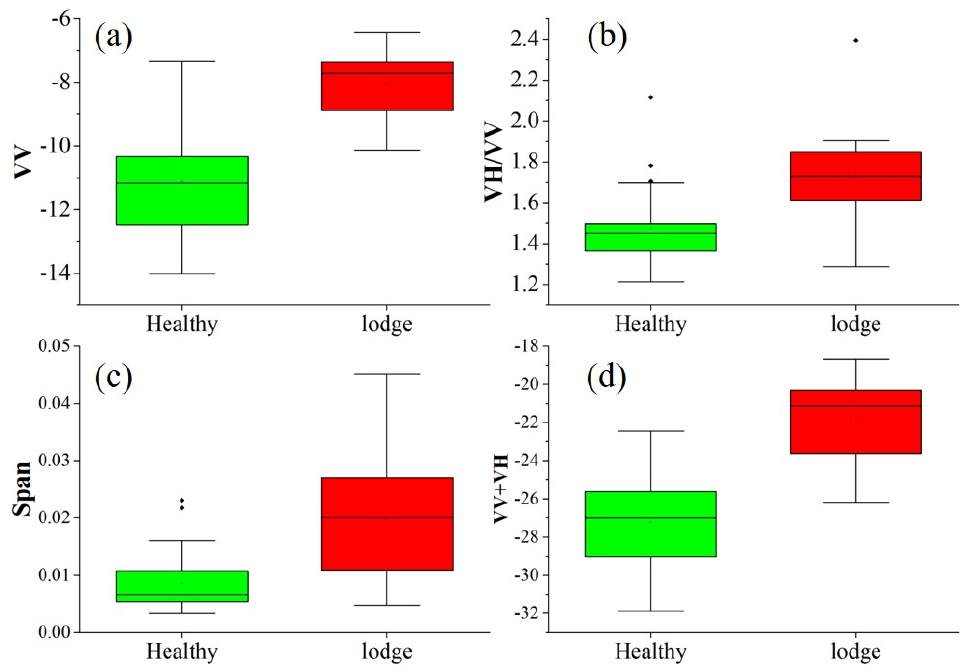
Figure 7. The variation of VV ( a ), VV+VH ( b ), VH/VV ( c ), and Span ( d ) for healthy and lodged paddy rice.